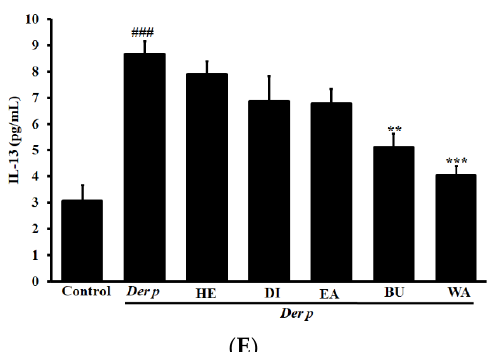
Figure 5. Effects of different fractions of garlic extracts (80 mg/kg) on ( A ) IL-12, ( B ) INF-γ, ( C ) IL-4, ( D ) IL-5 and ( E ) IL-13 cytokine levels in the collected BALF of mice with Der p–induced allergic asthma. Data derived are presented herein as mean ± SEM. ### p < 0.001 versus the control group, * p < 0.05, ** p < 0.01 and *** p < 0.001 versus the Der p group.